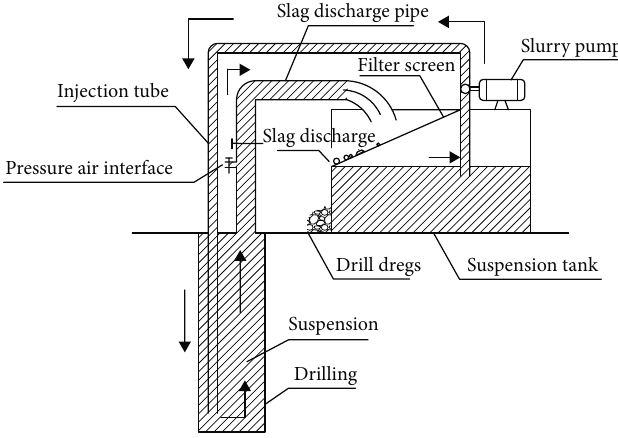
Figure 3: Schematic of the suspension-aided debris disposal.